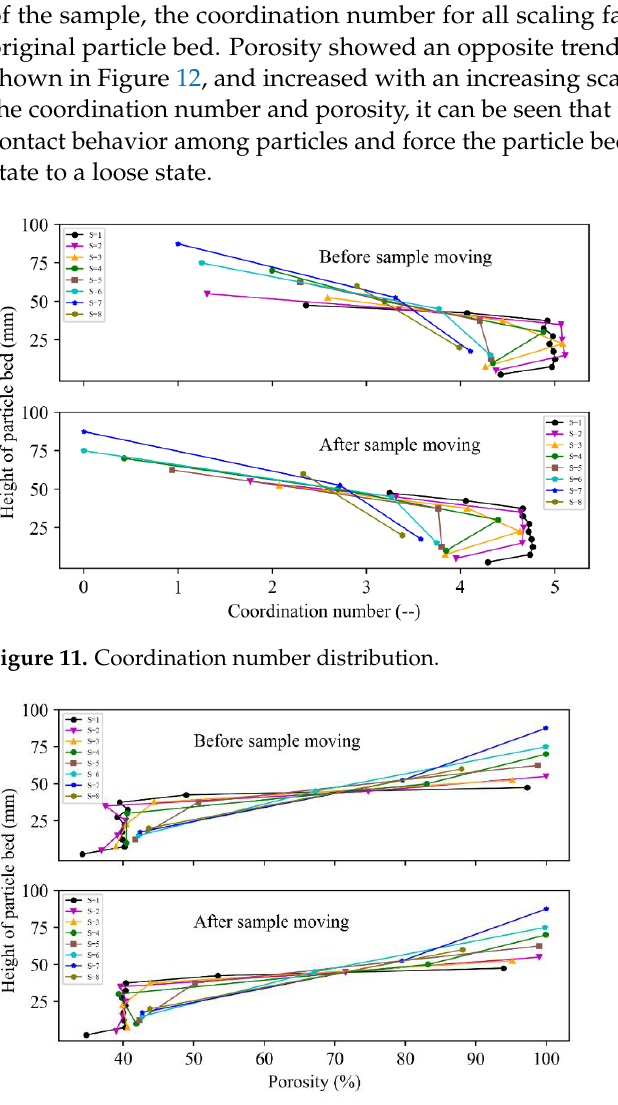
Figure 12. Porosity distribution. Figure 12. Porosity